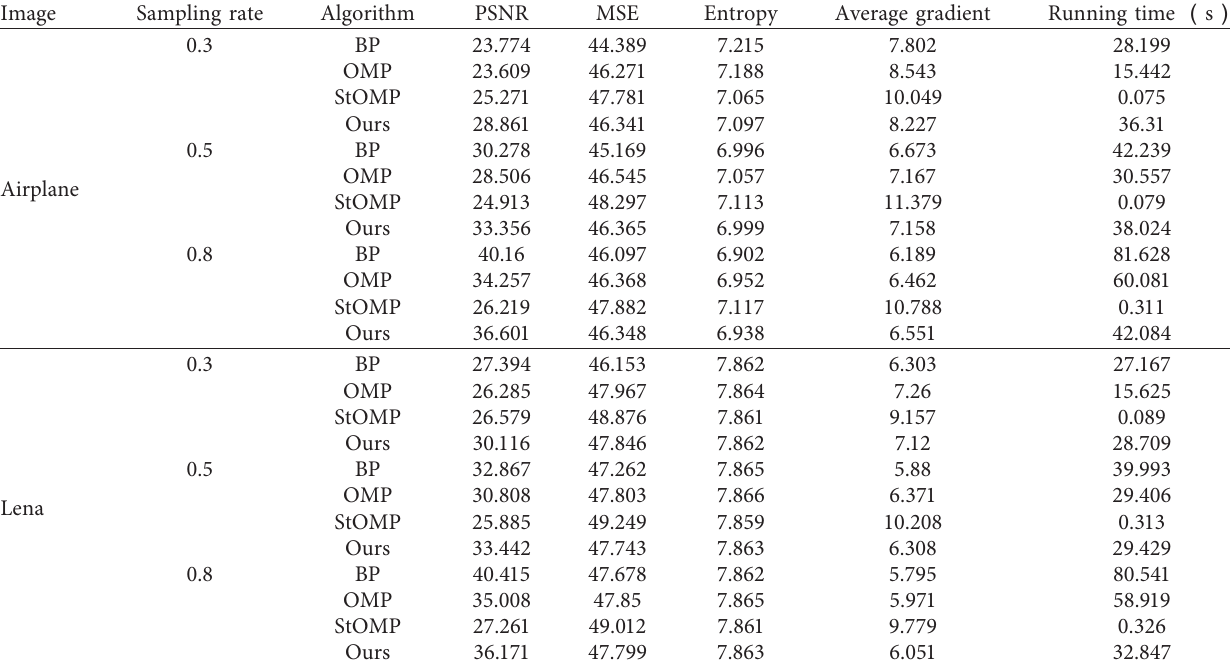
Table 1: Comparison of difference compressive sensing and reconstruction